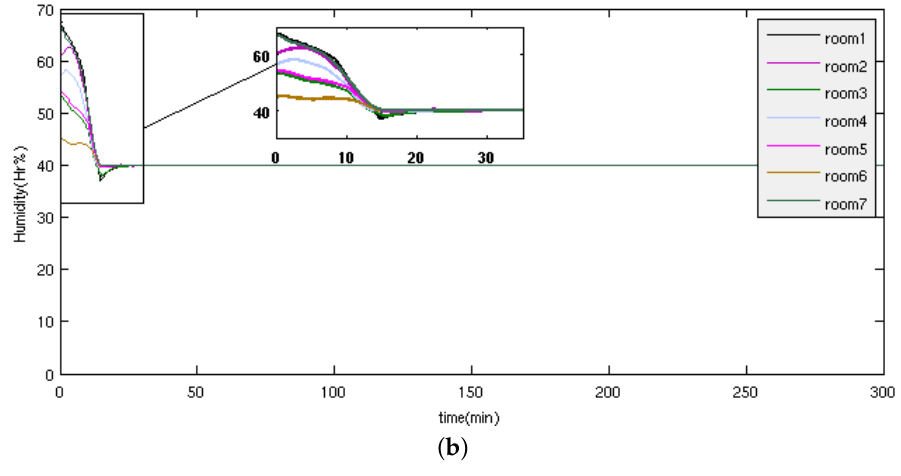
Figure 6. The numerical simulation lines represent the temperature and humidity in each room. ( a ) Simulation results of fuzzy control of temperature on seven closed control loops in the rooms. The response to a set reference temperature of 22 degrees, which is the accepted temperature in the operating rooms of many tropical countries. The simulation suggests different onset temperatures in each room, simulating different characteristics for each room. ( b ) Simulation results of fuzzy control of humidity on seven closed control loops in the rooms. The response to a set reference of 40% of relative humidity, which is the accepted humidity in the operating rooms for many tropical countries. Initial relative humidity is considered, as is temperature.